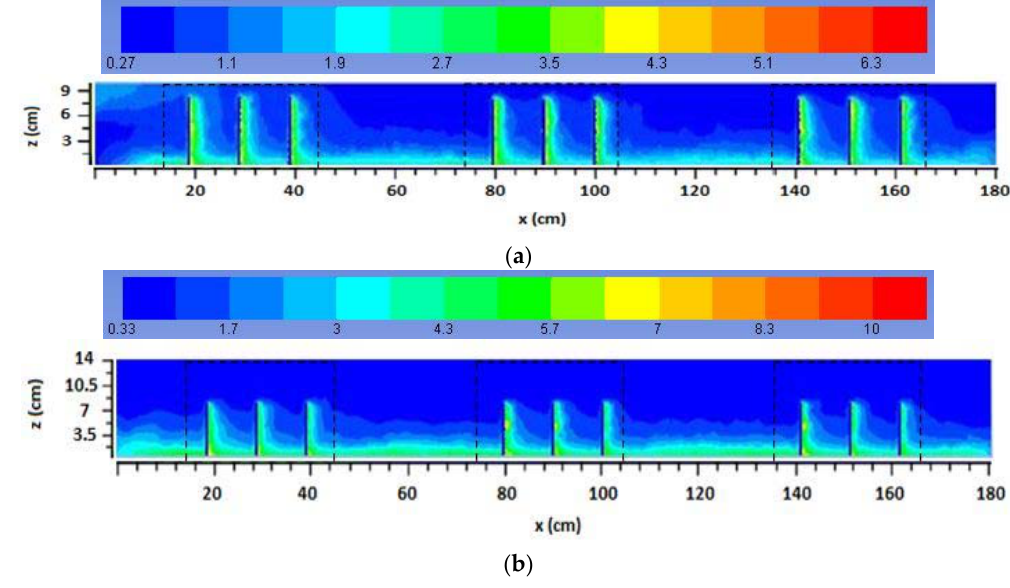
Figure 13. Distribution of turbulence intensity (%) at section y = 20.08 cm ( a ) for Case A, and ( b ) for Case B.